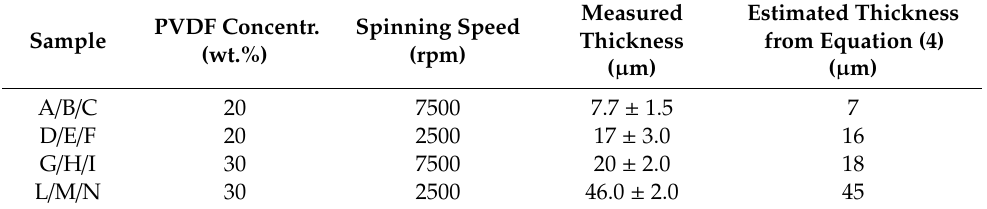
Table 2. Measured and estimated thickness for the produced